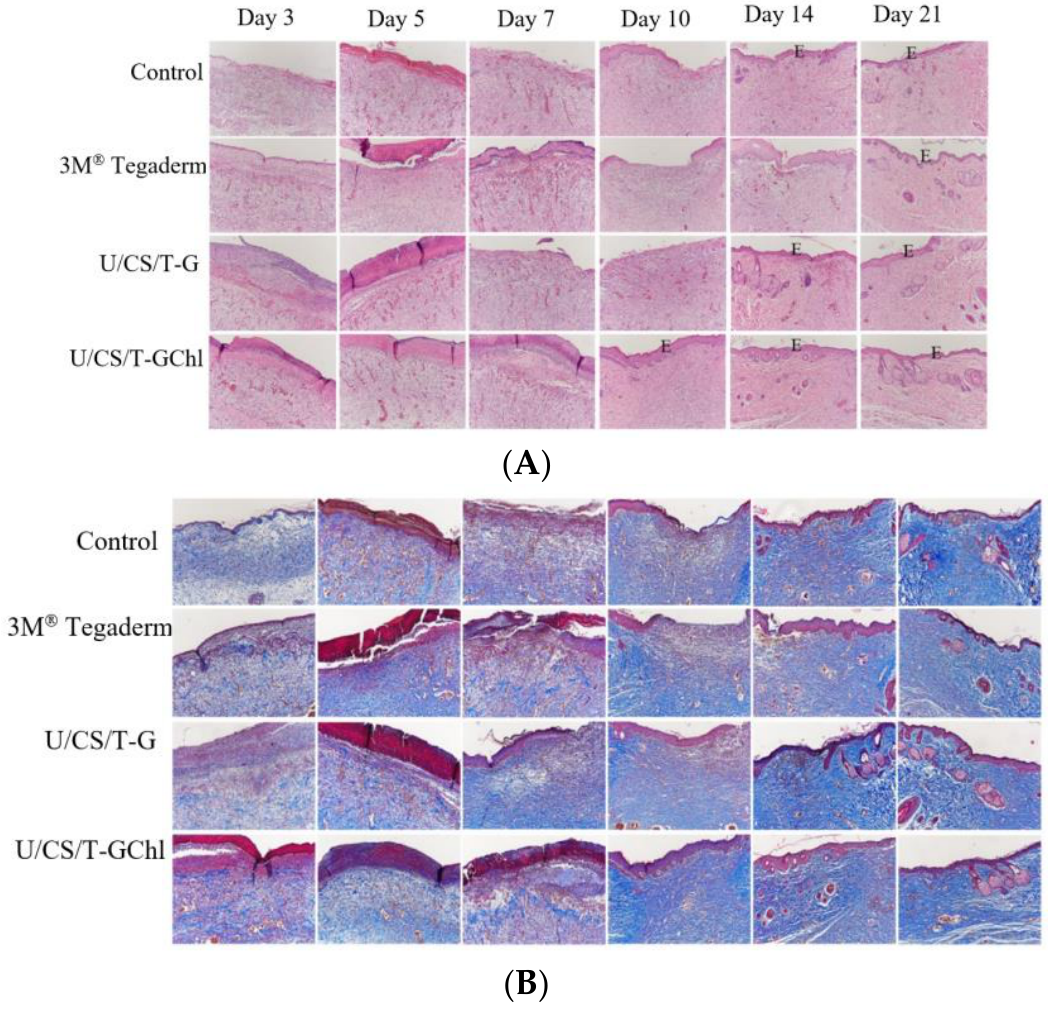
Figure 9. ( A ) Histological examination of skin wounds by H&E staining at several specific days (0–21 days) after surgery in SD rats. E: Epidermis. The control group is the open wound without any dressing. (100×) ( B ) Histological examination of collagen of skin wounds by Masson’s trichrome (MT) staining, 3 days up to 21 days in SD rats. The control group is the open wound without any dressing. (100×).